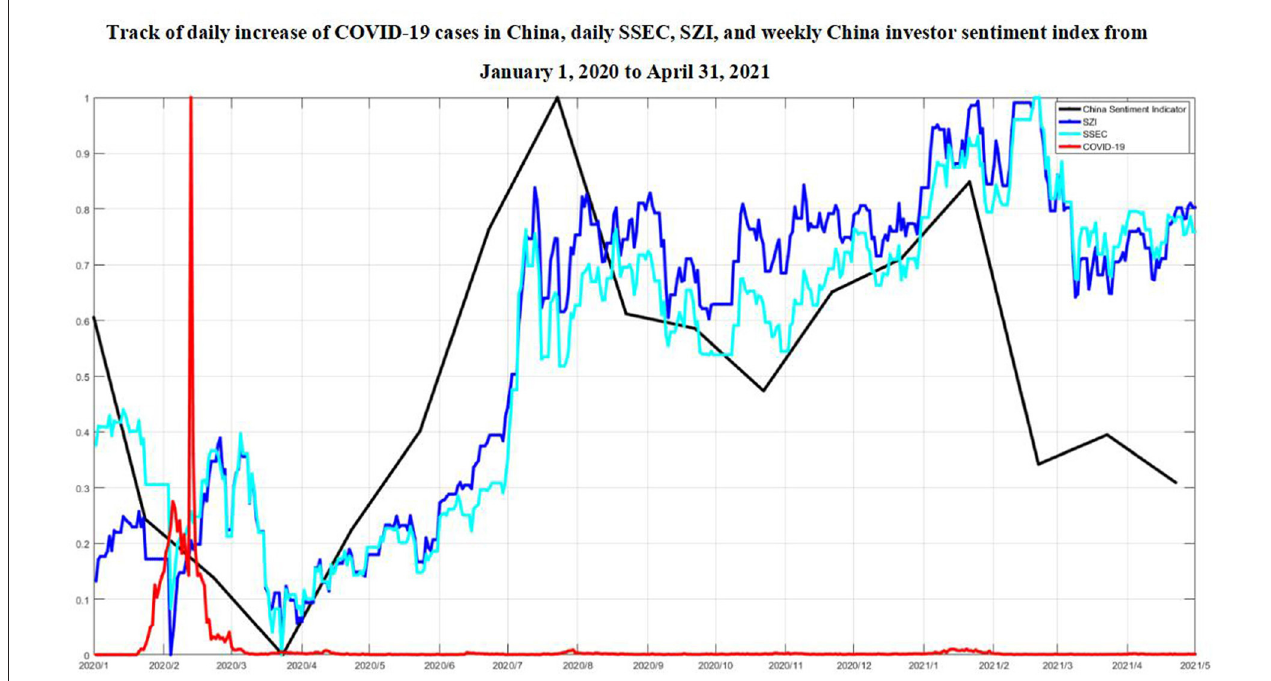
FIGURE 1 | Track of daily increase of COVID-19 cases in China, daily SSEC, SZI, and weekly normalized China investor sentiment index from January 1, 2020 to April 31, 2021.